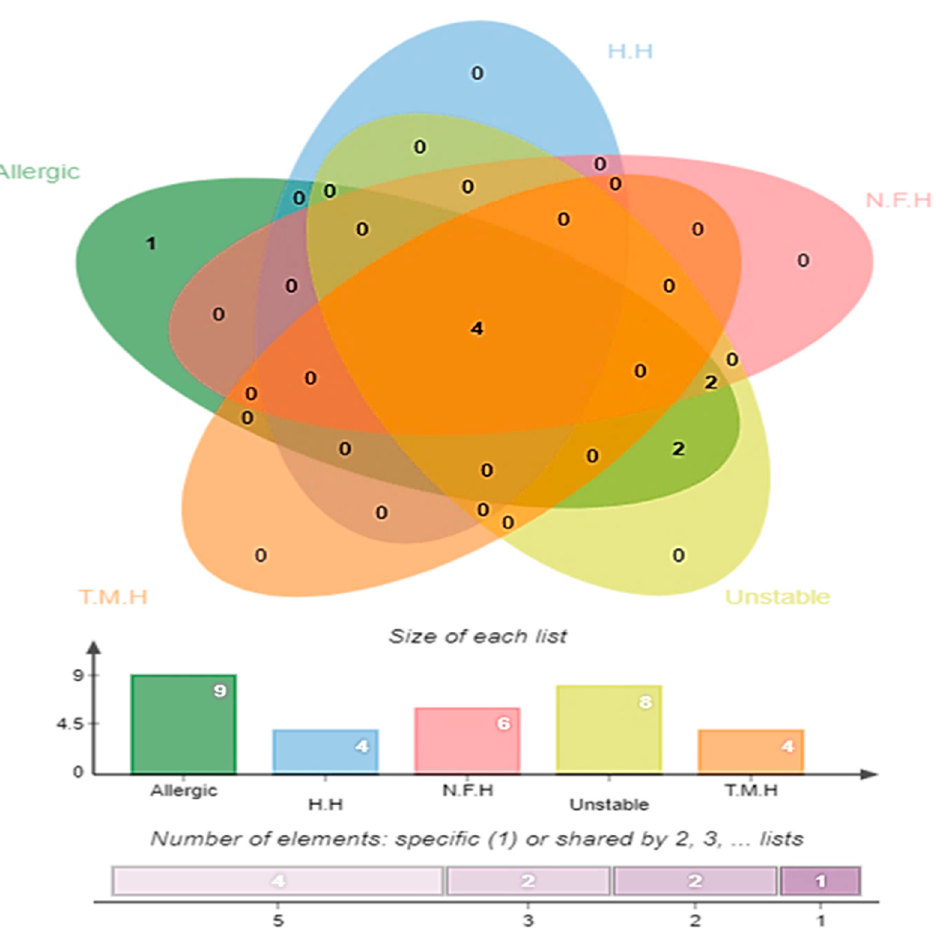
Figure 4. Number of host homologous (H.H) normal microbiota homologous (N.F.H.) transmem- brane helices (T.H.M), unstable and allergen protein sequences out of 36 virulent